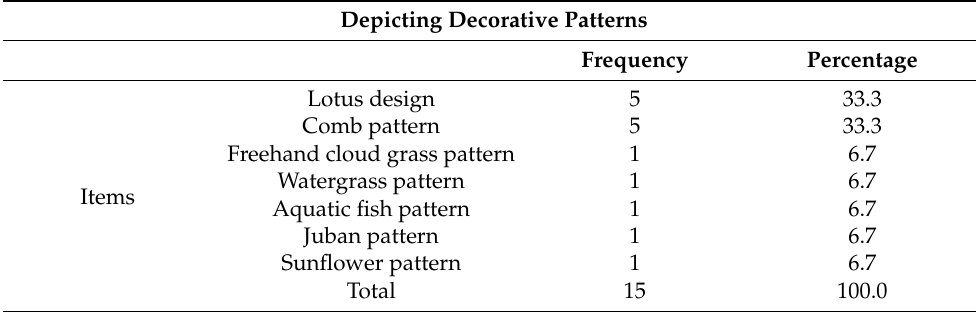
Table 4. Sample description statistics of Xiaopi kiln ancient ceramics depiction and